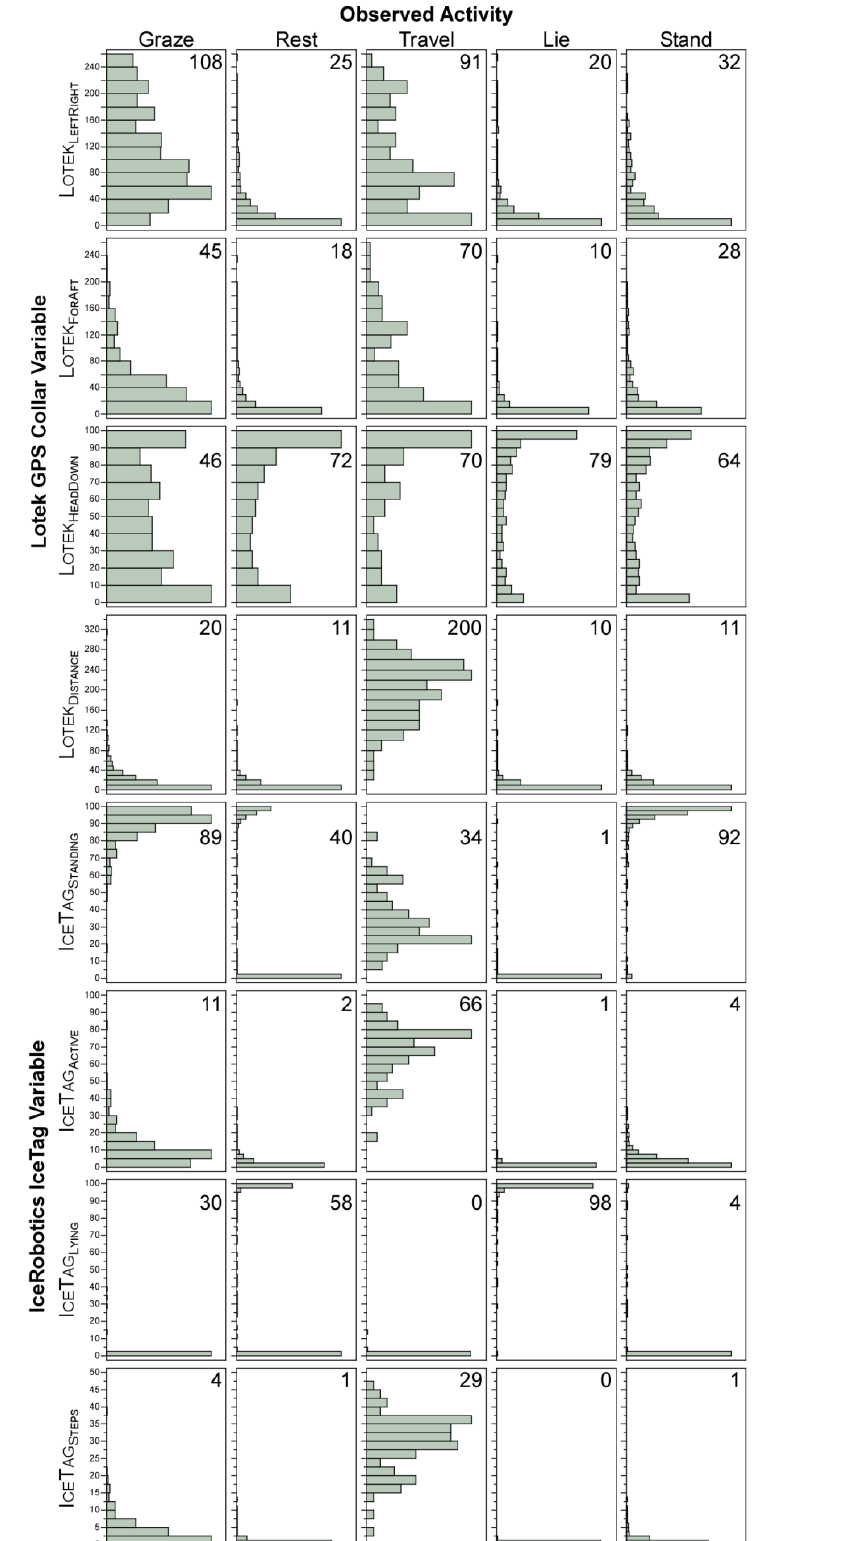
Figure 1. Frequency distributions of Lotek GPS collar and IceRobotics IceTag pedometer readings according to activity category. Graze, Rest and Travel results are based on 1,475 five-minute intervals; Stand and Lie results are based on 1,463 five-minute observations. Number in each panel is the